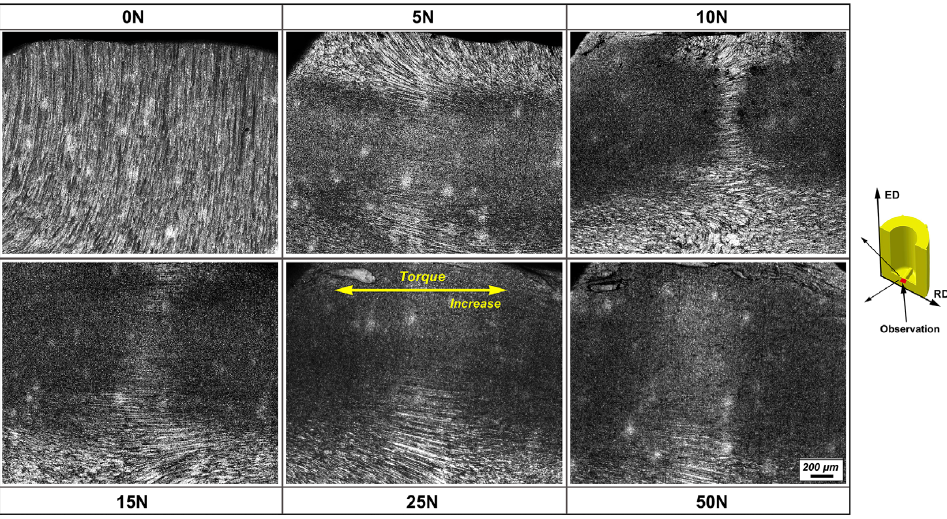
Figure 7. OM images of the bottom region of extruded samples selected from different N.